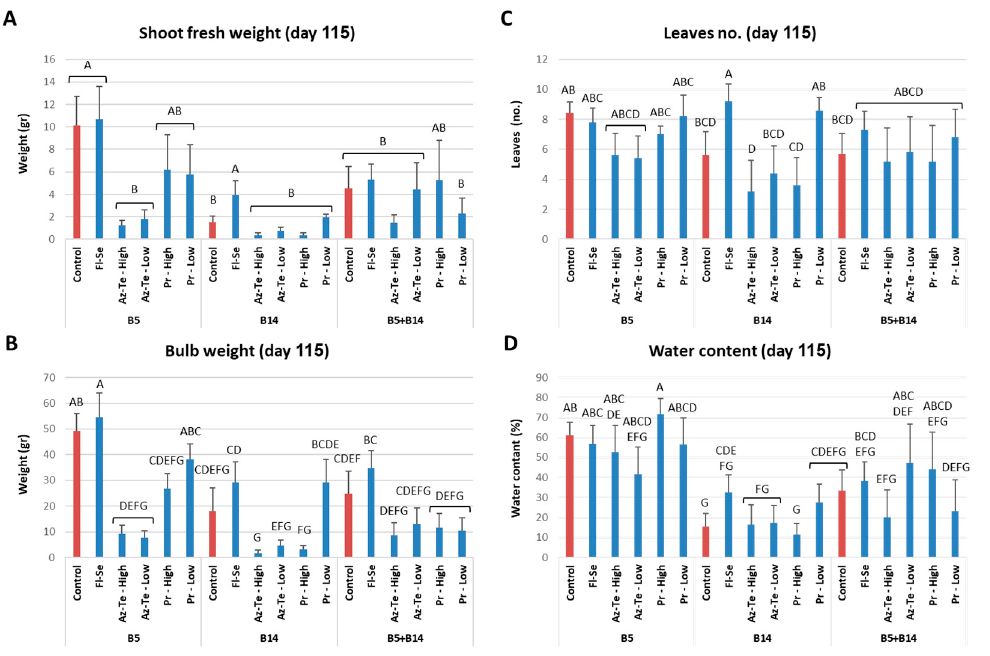
Figure 8. Effect of pesticide treatments on shoot weight of red onion plants (Noam cv.) 115 days after germination. The experiment and abbreviations are described in Figure 2. The harvest evaluation included the plants’ shoot fresh weight ( A ), bulbs’ wet weight ( B ), phenological development (number of leaves, C ), and water content ( D ). B5- F. acutatum , B14- F. oxysporum f. sp. cepae . Bars indicate the mean of five (Prochloraz and Az-Te) or 10 (Fl-Se) biological replications (pots). Controls (red columns) are plants without fungicides. Error bars are standard errors. Different letters above the chart’s bars (A–G) represent a significant difference ( p < 0.05) in the ANOVA